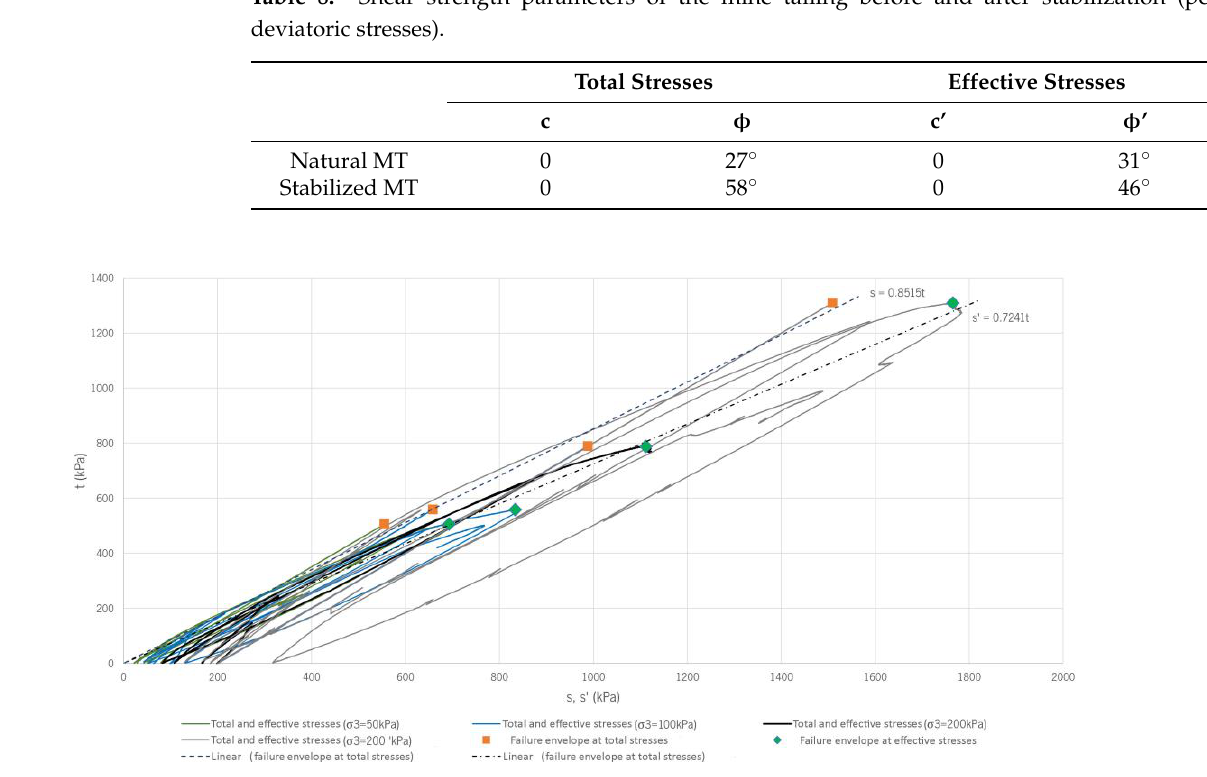
Table 8. Shear strength parameters of the mine tailing before and after stabilization (peak deviatoric stresses).